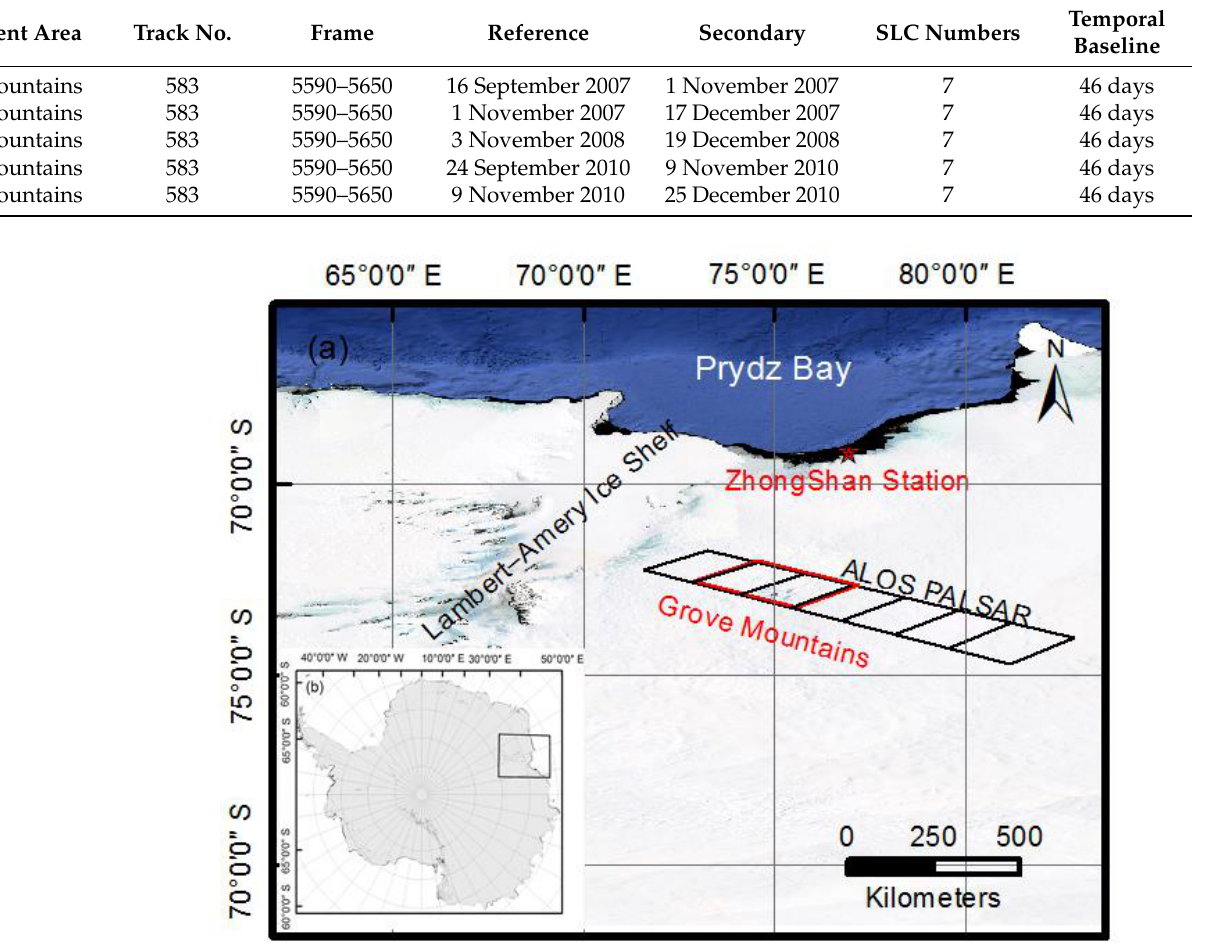
Figure 2. The coverage and map projection of ALOS PALSAR images ( a ) and the location of the Grove Mountains area ( b ). The black rectangle in ( b ) shows the black box in ( a ). The red rectangle and red pentacle indicate the Grove Mountains areas and the Zhongshan station, respectively.